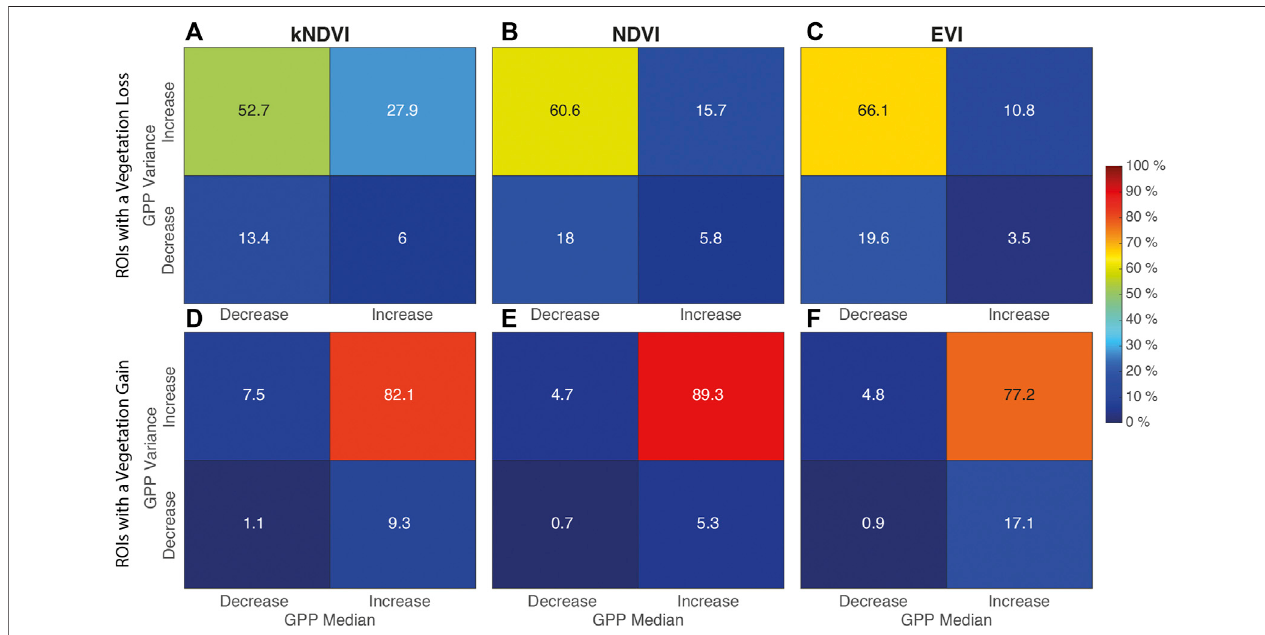
FIGURE 10 | Percentage distribution of combinations of increase/decrease in the GPP spatial median/variance within the ROIs. (A) – (C) Rois with vegetation loss. (D) – (F) Rois with vegetation gain.